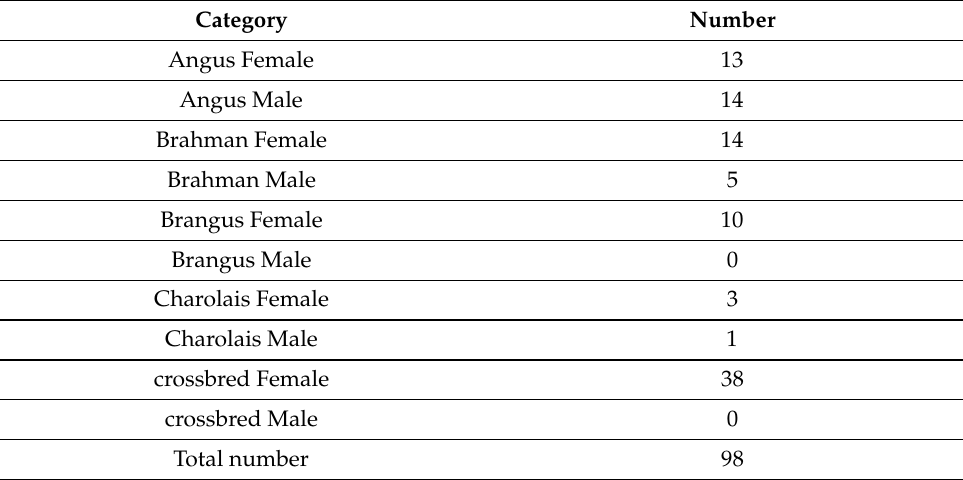
Table 2. The number of cattle of different breeds and